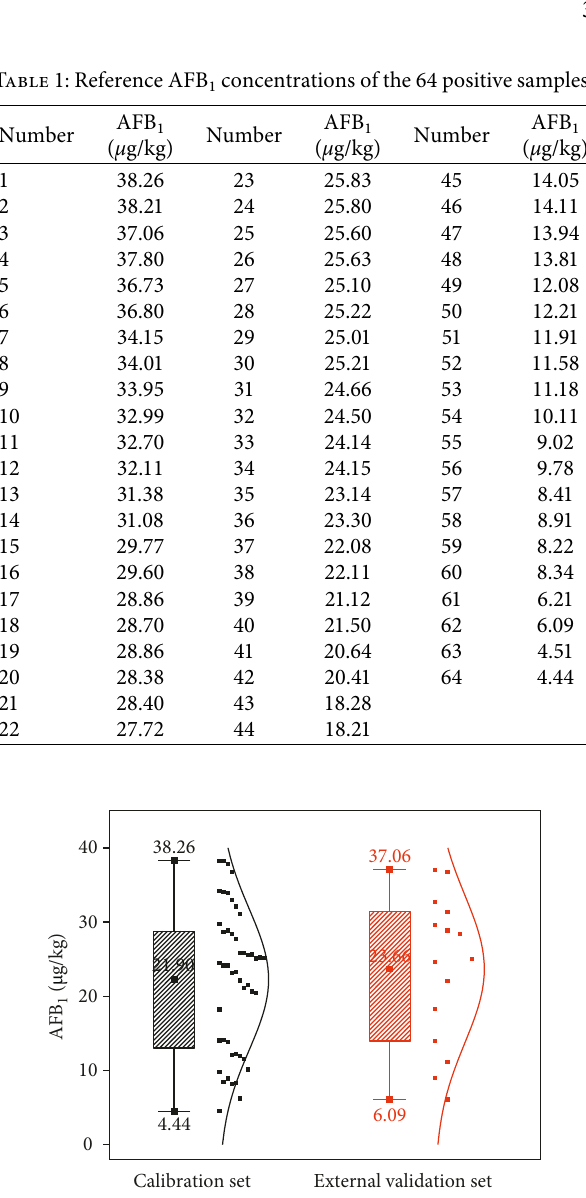
Figure 1: The statistics of reference AFB calibration and external validation